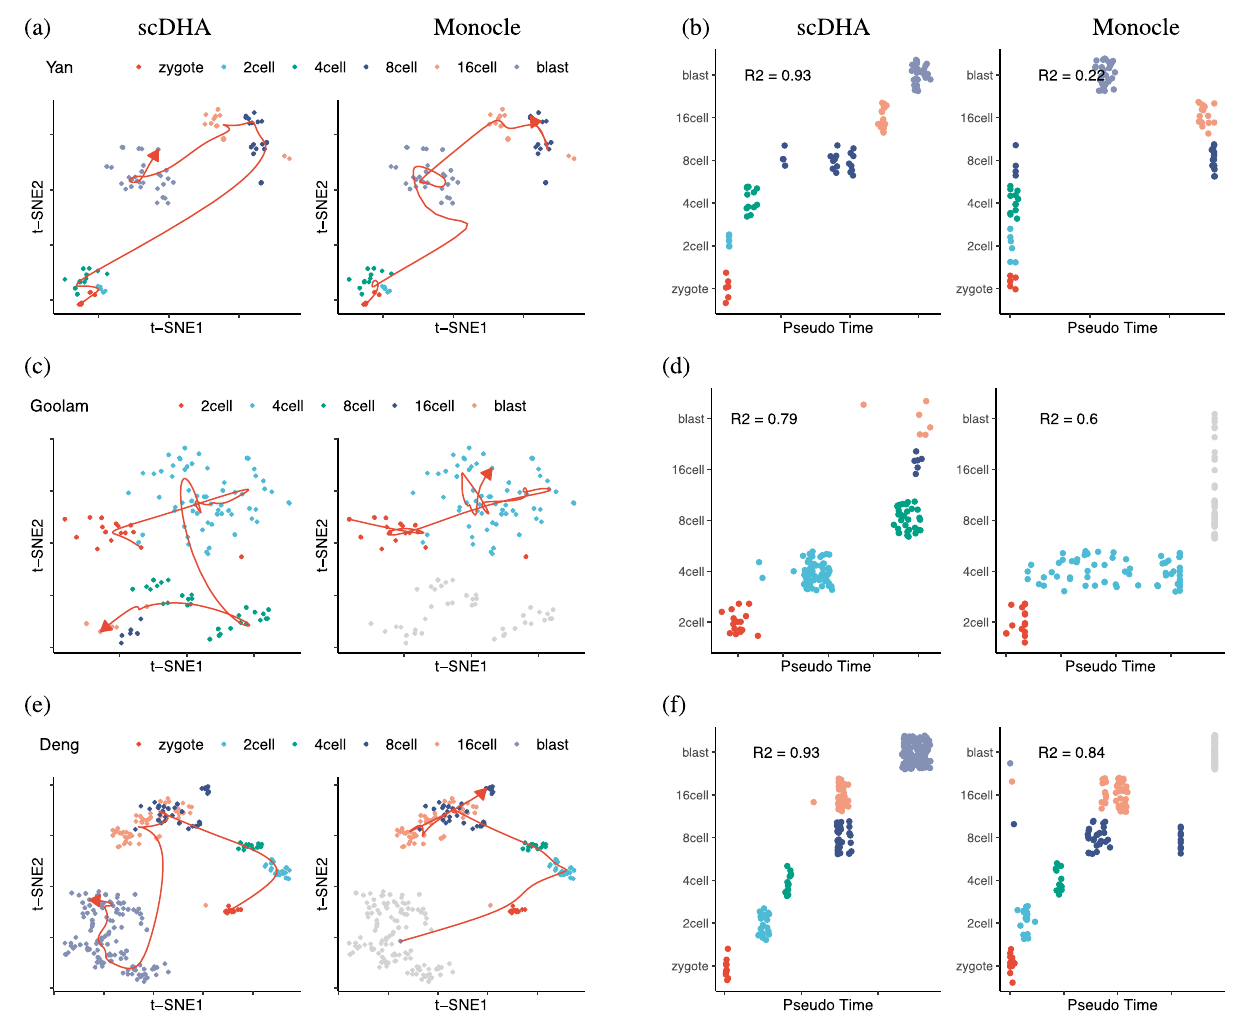
Fig. 3 Pseudo-time inference of three mouse embryo development data sets (Yan, Goolam, and Deng) using scDHA and Monocle. a Visualized time- trajectory of the Yan data set in the fi rst two t-SNE dimensions using scDHA (left) and Monocle (right). b Pseudo-temporal ordering of the cells in the Yan data set. The horizontal axis shows the inferred time for each cell while the vertical axis shows the true developmental stages. c , d Time-trajectory of the Goolam data set. Monocle is unable to estimate the time for most cells in 8cell, 16cell, and blast (colored in gray). e , f Time-trajectory of the Deng data set. Monocle is unable to estimate the pseudo-time for most blast